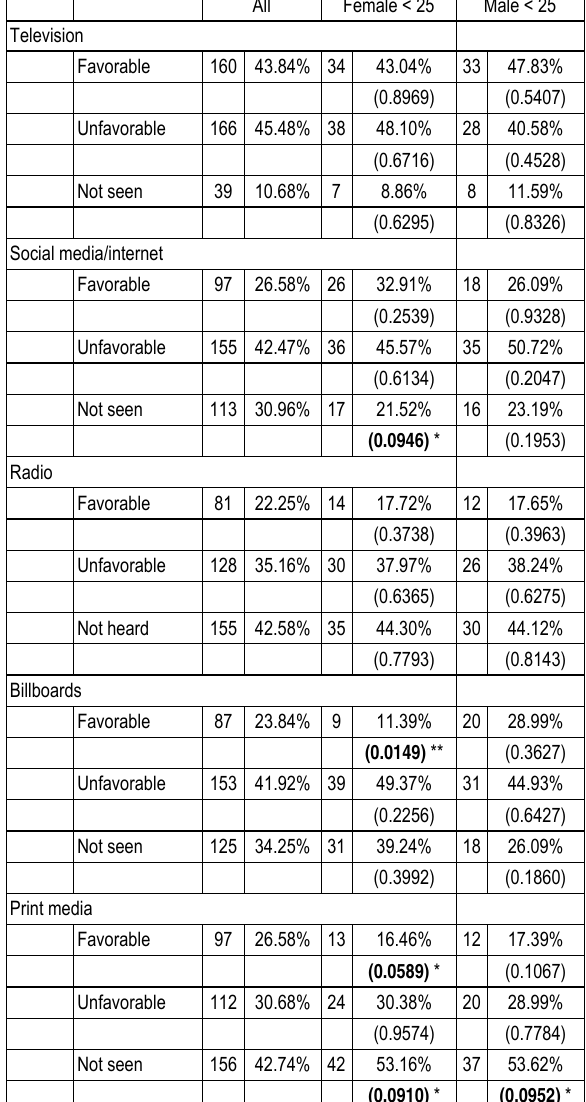
Table 3 (cont.). Compare male and female by age This table shows the overall results and the results by gender for specific age groups that had significant differences. The table shows the total number of respondents for each category per question and the percent. The number in the parenthesis is the probability that the percentage responses are statistically significantly different from the overall survey responses based on a Chi-square statistic. One aste- risk indicates significance at the 10% level, two asterisks at the 5% level and 3 asterisks within the 1%